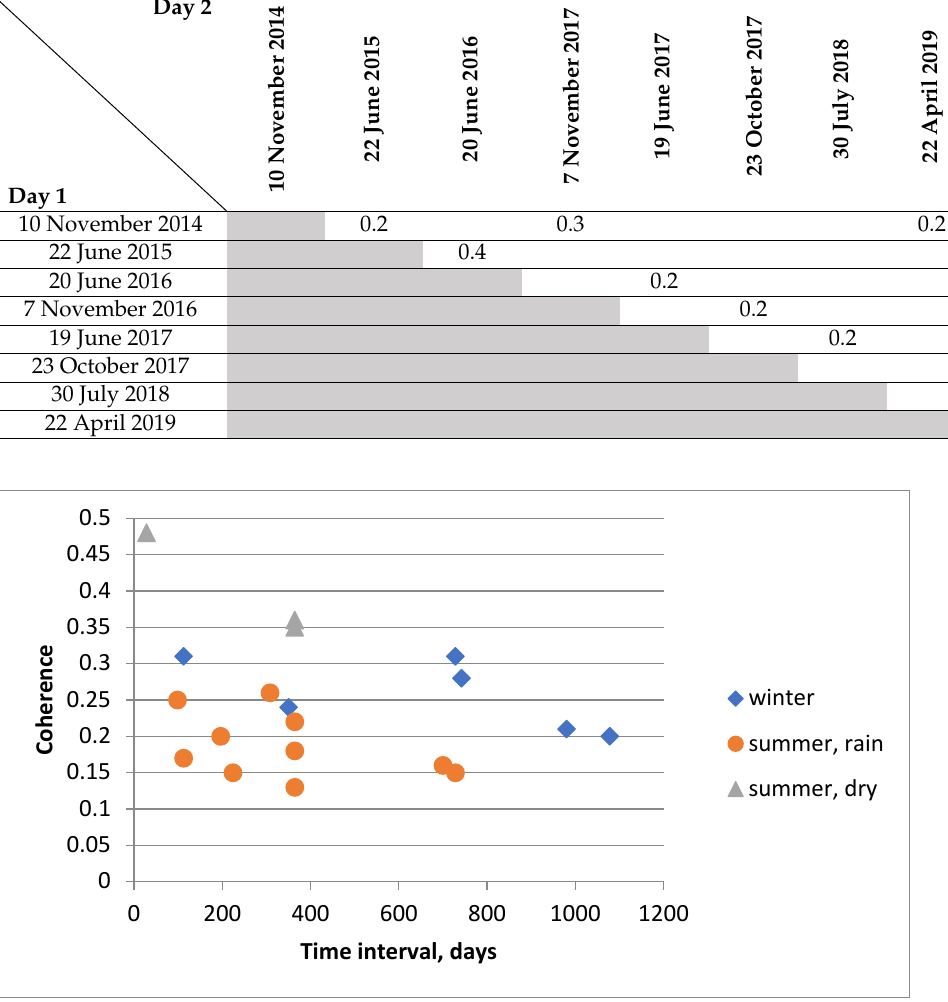
Table 5. ALOS-2 coherences, track 128.